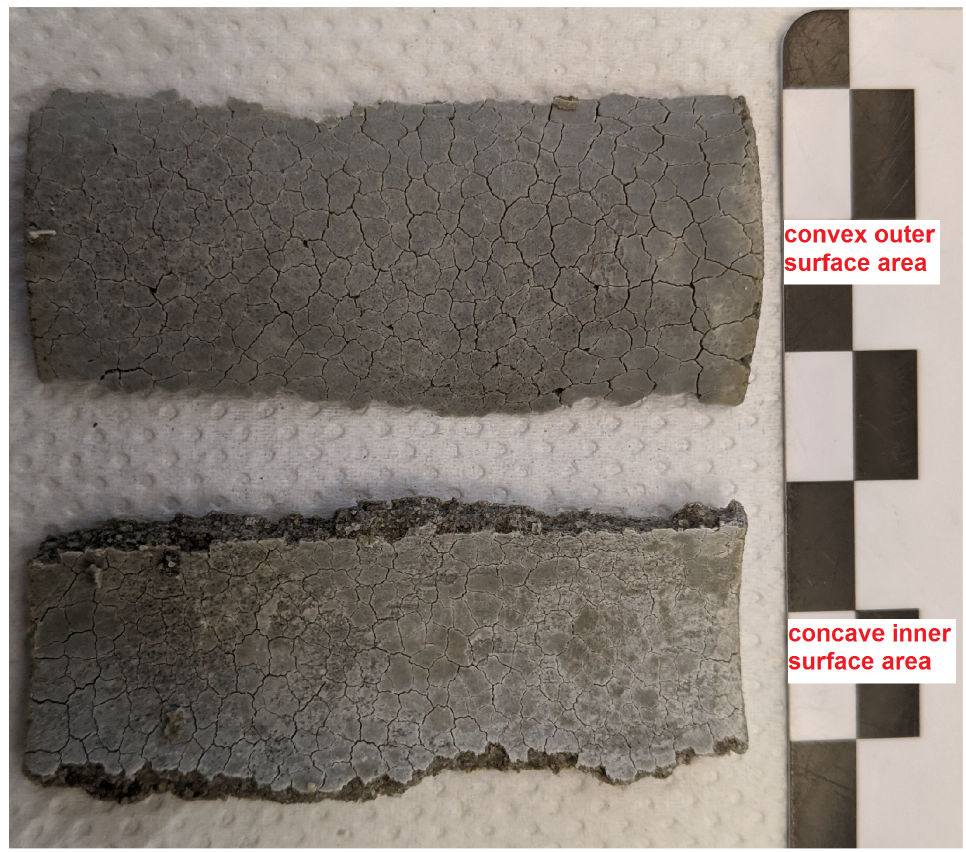
Figure 10. Segments of a hollow cylinder (OPC H) at the time of mechanical failure after 38 days (non-constrained stress cell) of storage in 3.0gL SO 2– 4